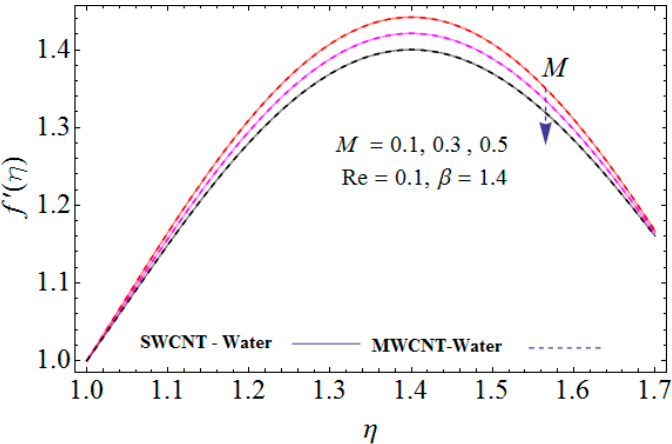
Figure 5. The impact of the Marangoni convection parameter versus the velocity field.